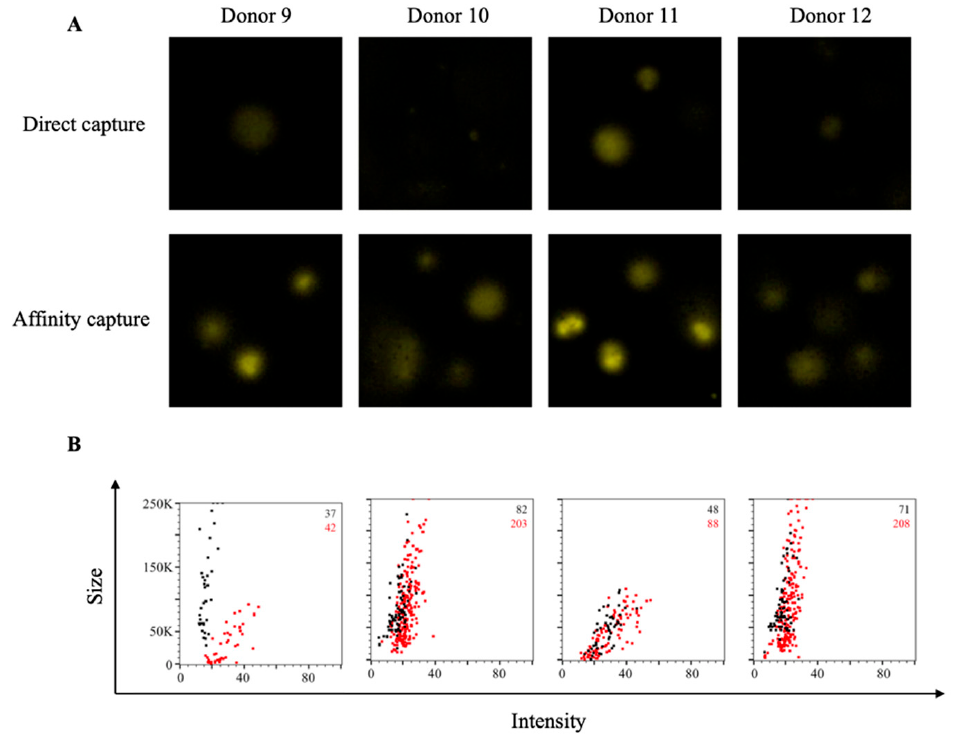
Figure 5. Improved sensitivity of gH-specific ASC through affinity capture of coating antigen. PBMC were stimulated in vitro and evaluated for antibody-secreting (ASC) reactivity against the gH pentamer complex protein from HCMV. ( A ) Representative wells images depicting antigen-specific IgG + ASC in wells coated directly with 10 µ g/mL of gH pentamer complex protein, or through affinity capture using the genetically encoded hexahistidine (6XHis) tag. Magnification and contrast enhancements were uniformly performed on all images to aid their visualization in publication. ( B ) gH-specific FluoroSpots were merged into FCS files and visualized as bivariate plots. FluoroSpots originating from assay wells in which gH pentamer complex was directly captured on the membrane (black dots) or through affinity capture (red) are shown as overlays. The combined number of FluoroSpots detected in replicate wells for each of the respective donors is indicated in the inset using the same red/black color code.